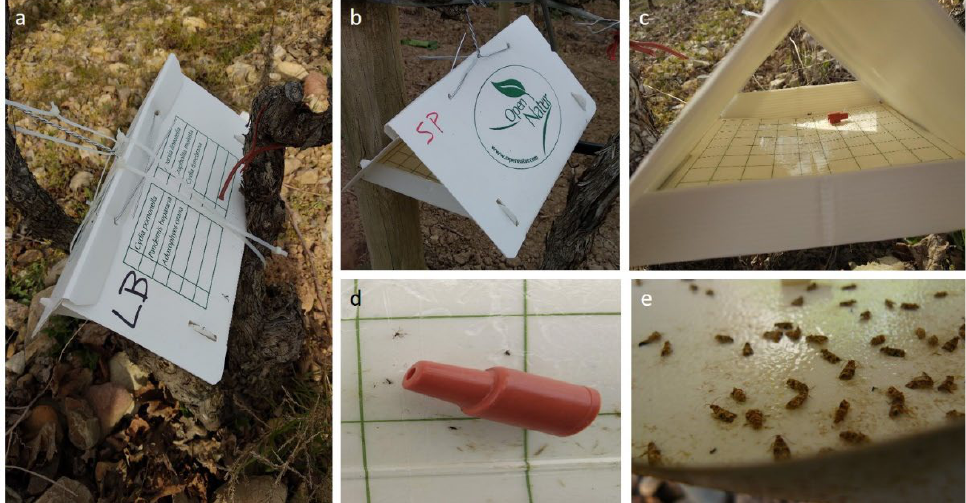
Figure 5. Delta traps placed in the field for flight monitoring: ( a , b ) Traps; ( c ) gummed bottom; ( d ) sex pheromone; ( e ) adults captured.